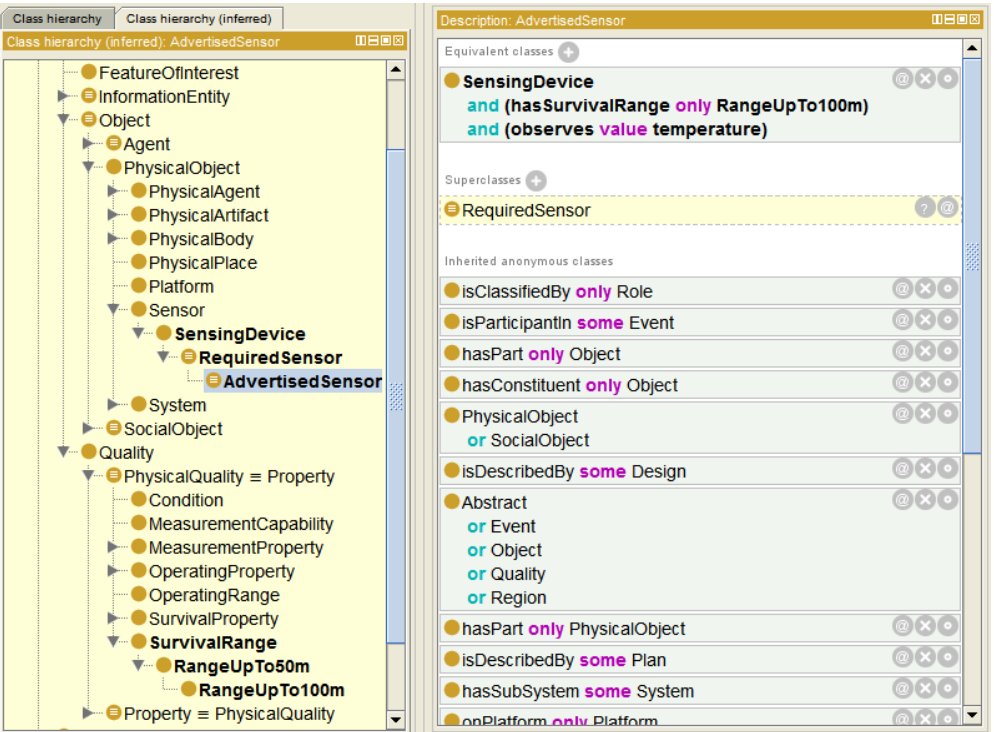
Figure 13. Example of a plugIn match of the survival range as screenshot in